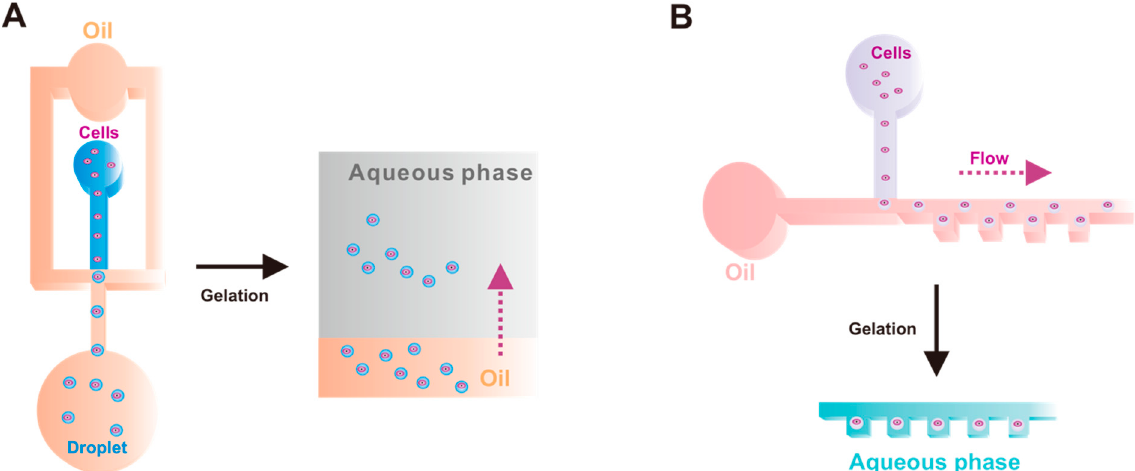
Figure 2. Droplet micro fl uidic systems. ( A ) Droplet culture. ( B ) Microtrap culture.